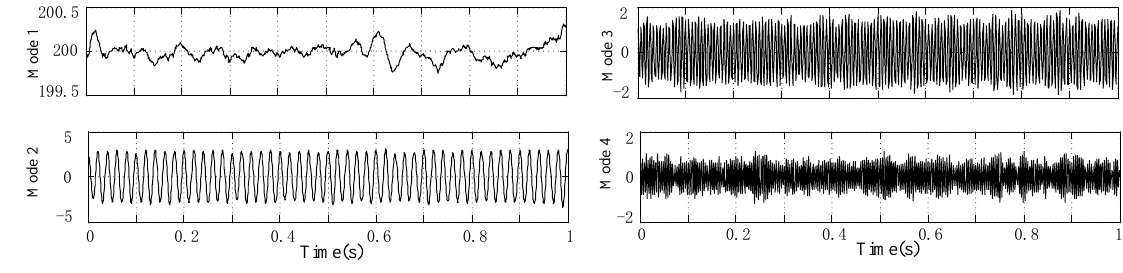
Figure 13. The decomposed modes of VMD-HT algorithm.